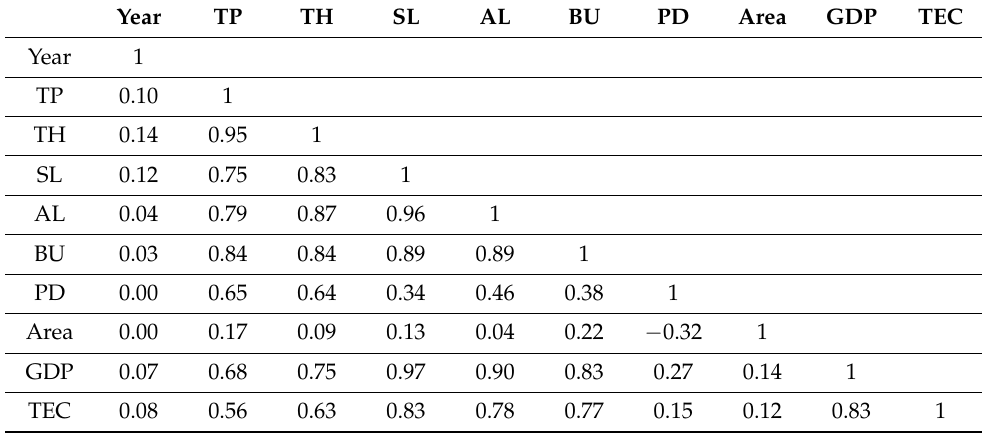
Table 2. The correlation coefficients between